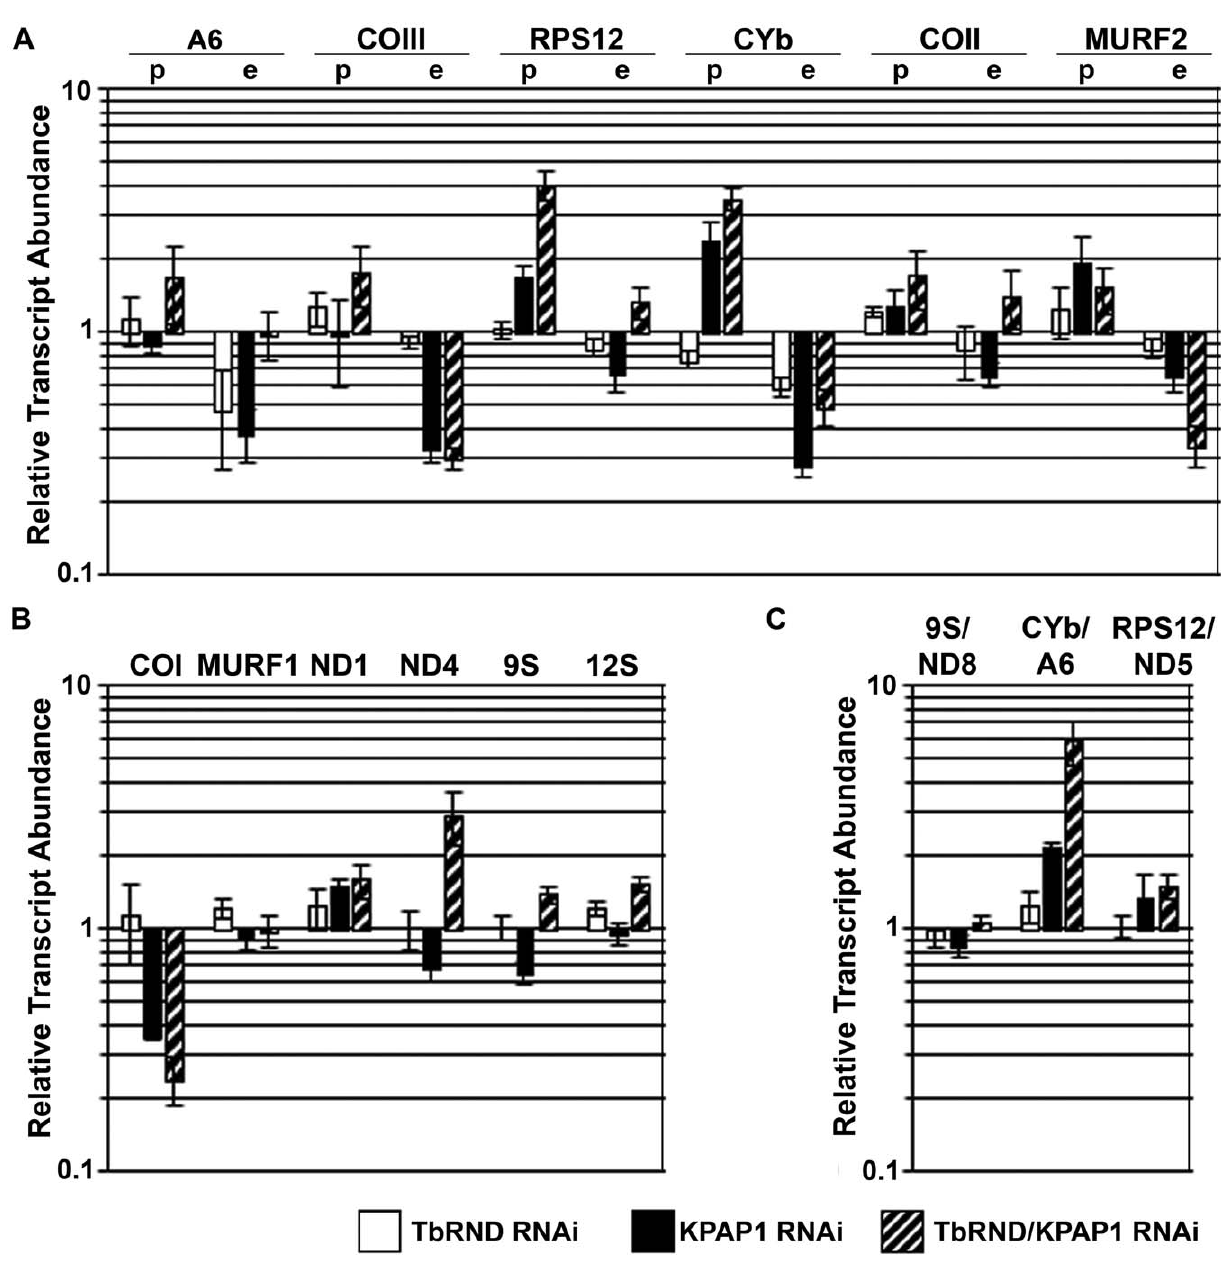
Figure 2. Mitochondrial transcript abundances in TbRND, KPAP1, and dual-TbRND/KPAP1 RNAi cell lines. Relative transcript levels of indicated transcripts compared to levels prior to RNAi induction, as determined by quantitative RT-PCR normalized to 18S RNA. A. Edited transcripts. p, amplification with primers specific to the pre-edited form of the transcript; e, amplification with primers specific to the edited form. B. Never-edited transcripts. The abundance values for 9S and 12S rRNAs for the TbRND RNAi were published previously [26], but included here for the purposed of comparison. C. Pre-processed transcripts. Amplification with primers spanning two adjacent genes.